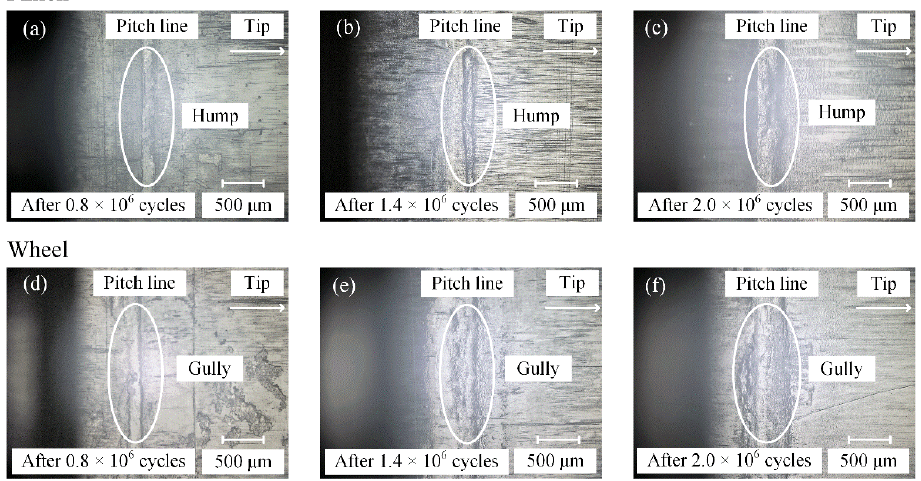
Fig. 8 Wear evolution for the 5 N·m load under the dry running